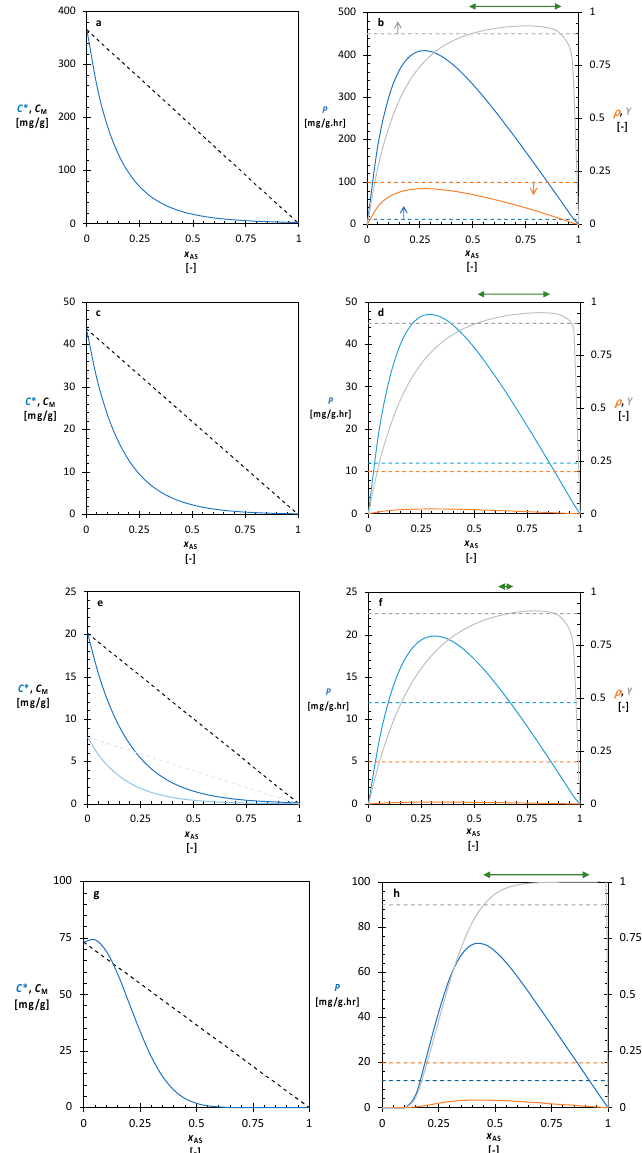
Figure 6. The isothermal phase diagram of solubility C * against antisolvent fraction x AS (left, a , c , e , g ) and productivity P , yield Y and suspension density r (right, b , d , f , h ) of: ( a , b ). NaBrO 3 in water with antisolvent EtOH, ( c , d ). ASN in water with antisolvent EtOH, ( e , f ). MFA in EtOH with antisolvent water, and ( g , h ). LOV in AcO with antisolvent water. All phase diagrams are at temperature T = 20 °C while in the case of the MFA system also the one at T = 45 °C is shown. The dashed line represents the dilution line with total concentration C M as a function of the antisolvent fraction x AS that results from the mixing of a saturated solution feed and a pure antisolvent feed. On the right, the predicted productivity P ( — ), yield Y ( — ) and slurry density r ( — ) in a continuous antisolvent crystallization process with a saturated feed and a pure antisolvent feed as a function of antisolvent fraction x AS are shown. The residence time for each system is 0.5 h. The dashed horizontal lines on the right indicate the process specifications: Y ≥ 90%, P ≥ 0.012 g/g.hr and ρ ≤ 20% while the optimal region of the antisolvent fraction is indicated with a green horizontal arrow above the graphs on the